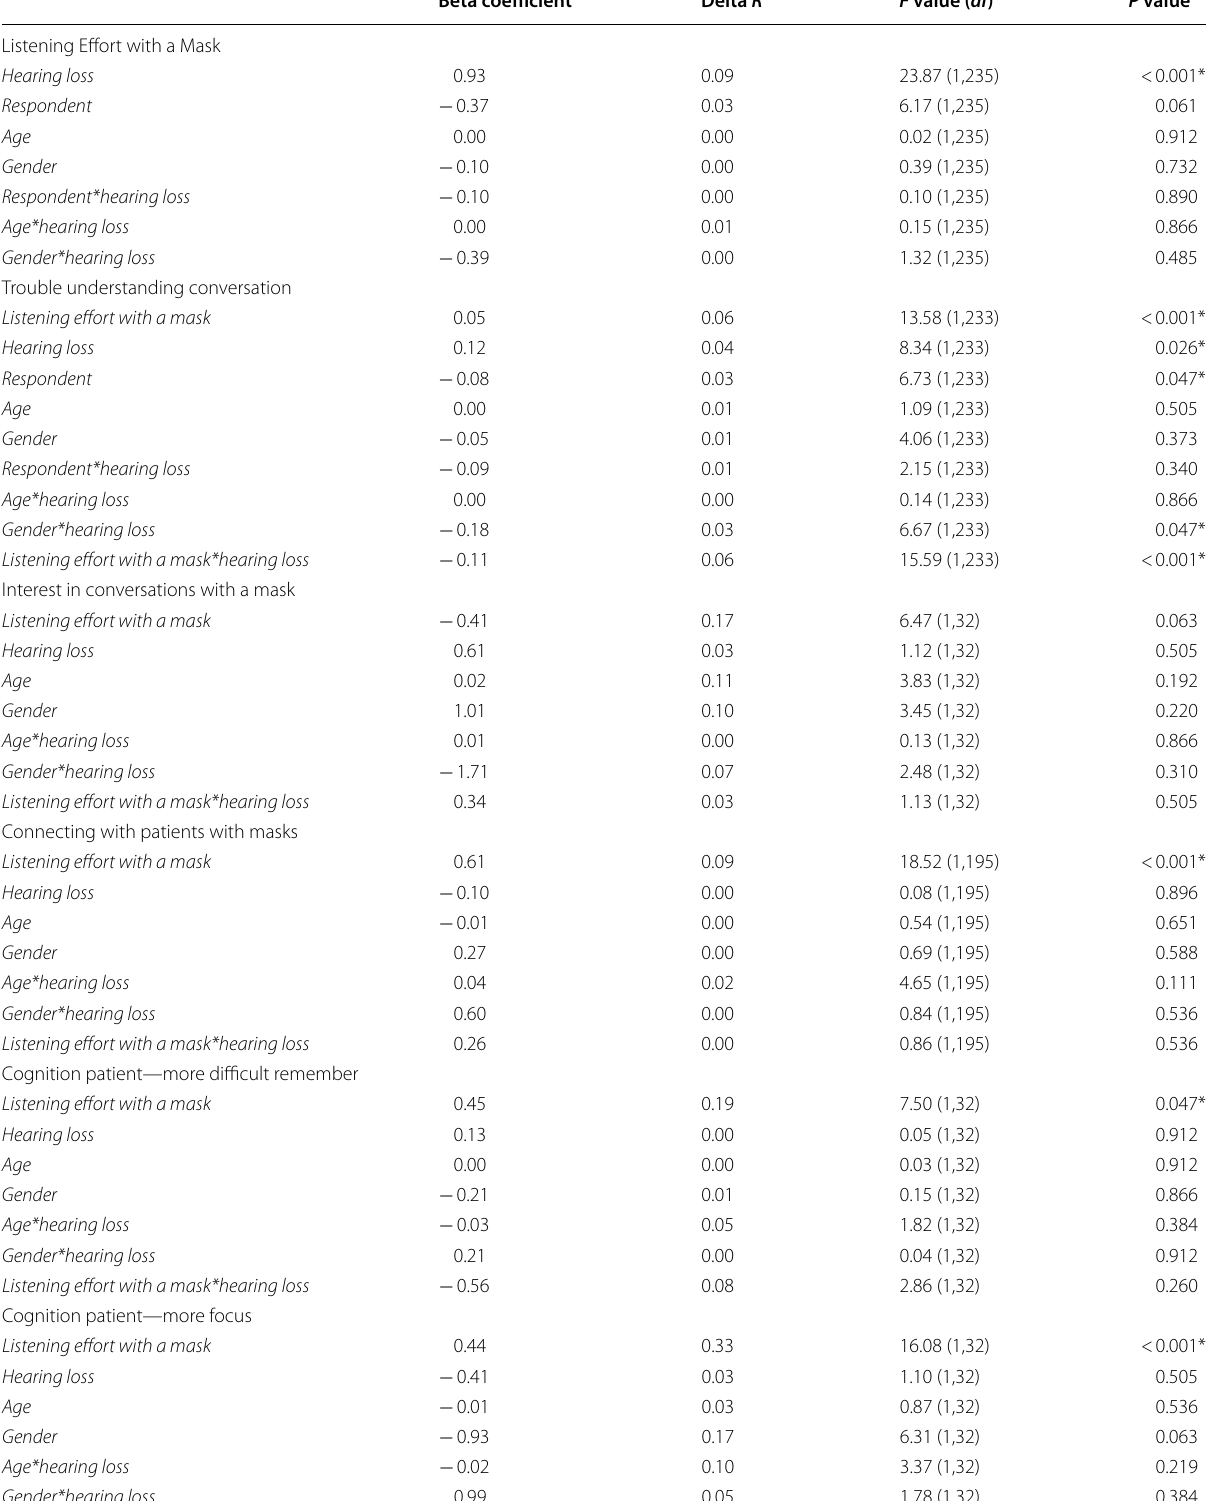
Table 2 Linear Regression